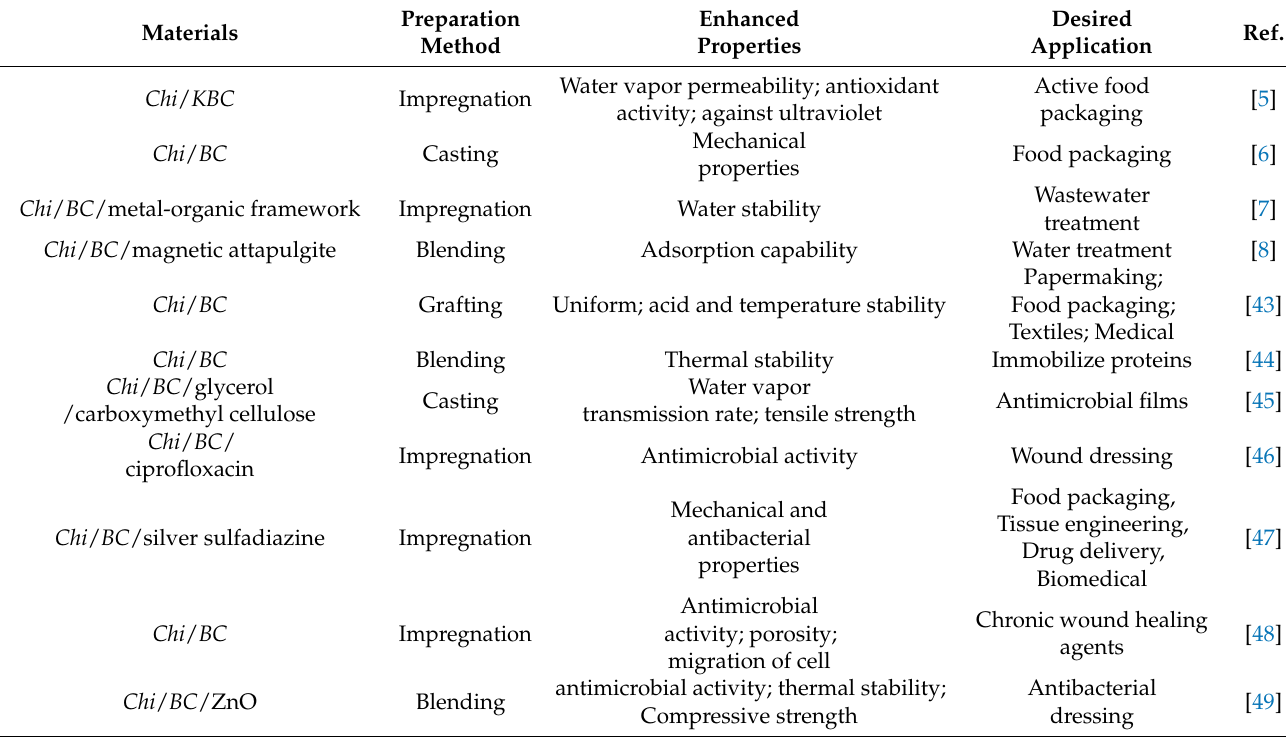
Table 1. List of recent research regarding the combination of Ch with BC or KBC and desired